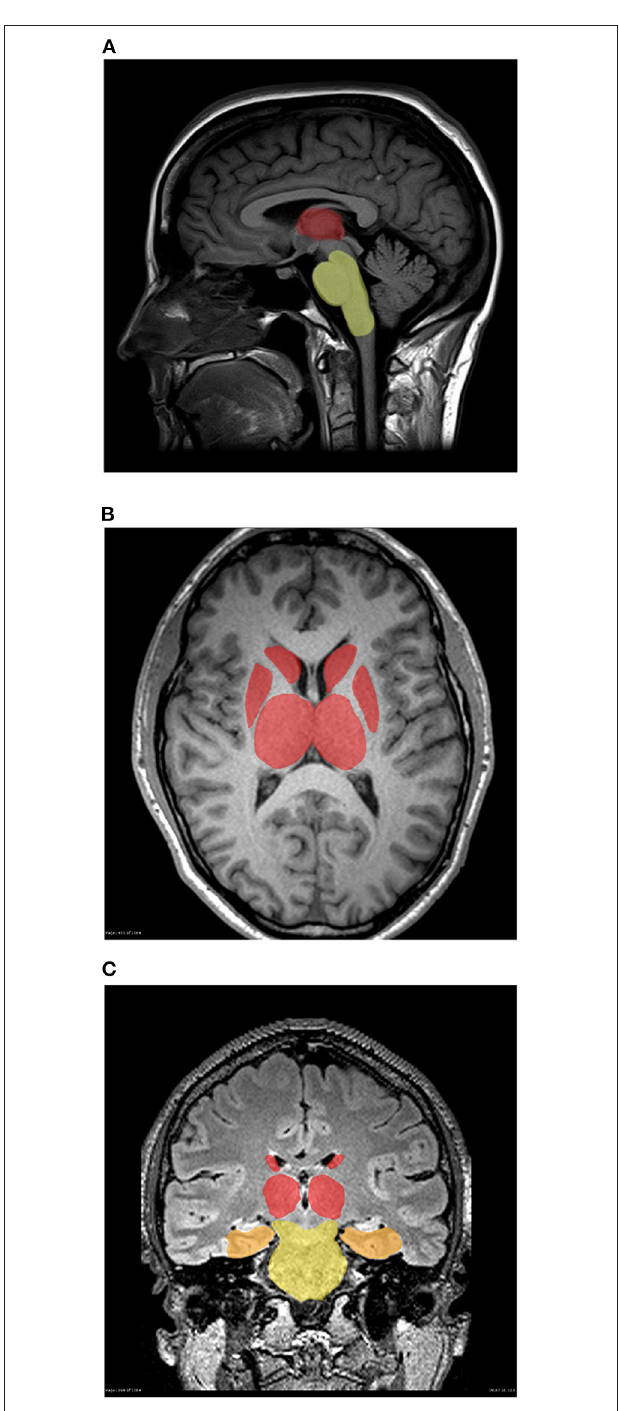
FIGURE 4 | (A–C) Three-dimensional mapping of deep brain structure demonstrating gradient of smallest to greatest diffusion abnormalities in individuals with migraine vs. controls (A) Sagital, (B) Axial, and (C) Coronal. Brainstem (yellow), amygdala (orange), thalamus, putamen and pallidum (red).